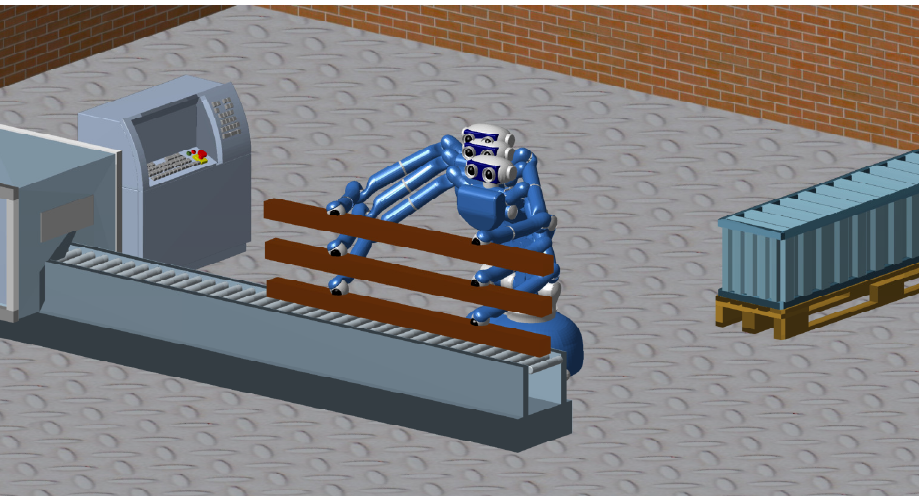
Figure 8. The third phase of the task: precise